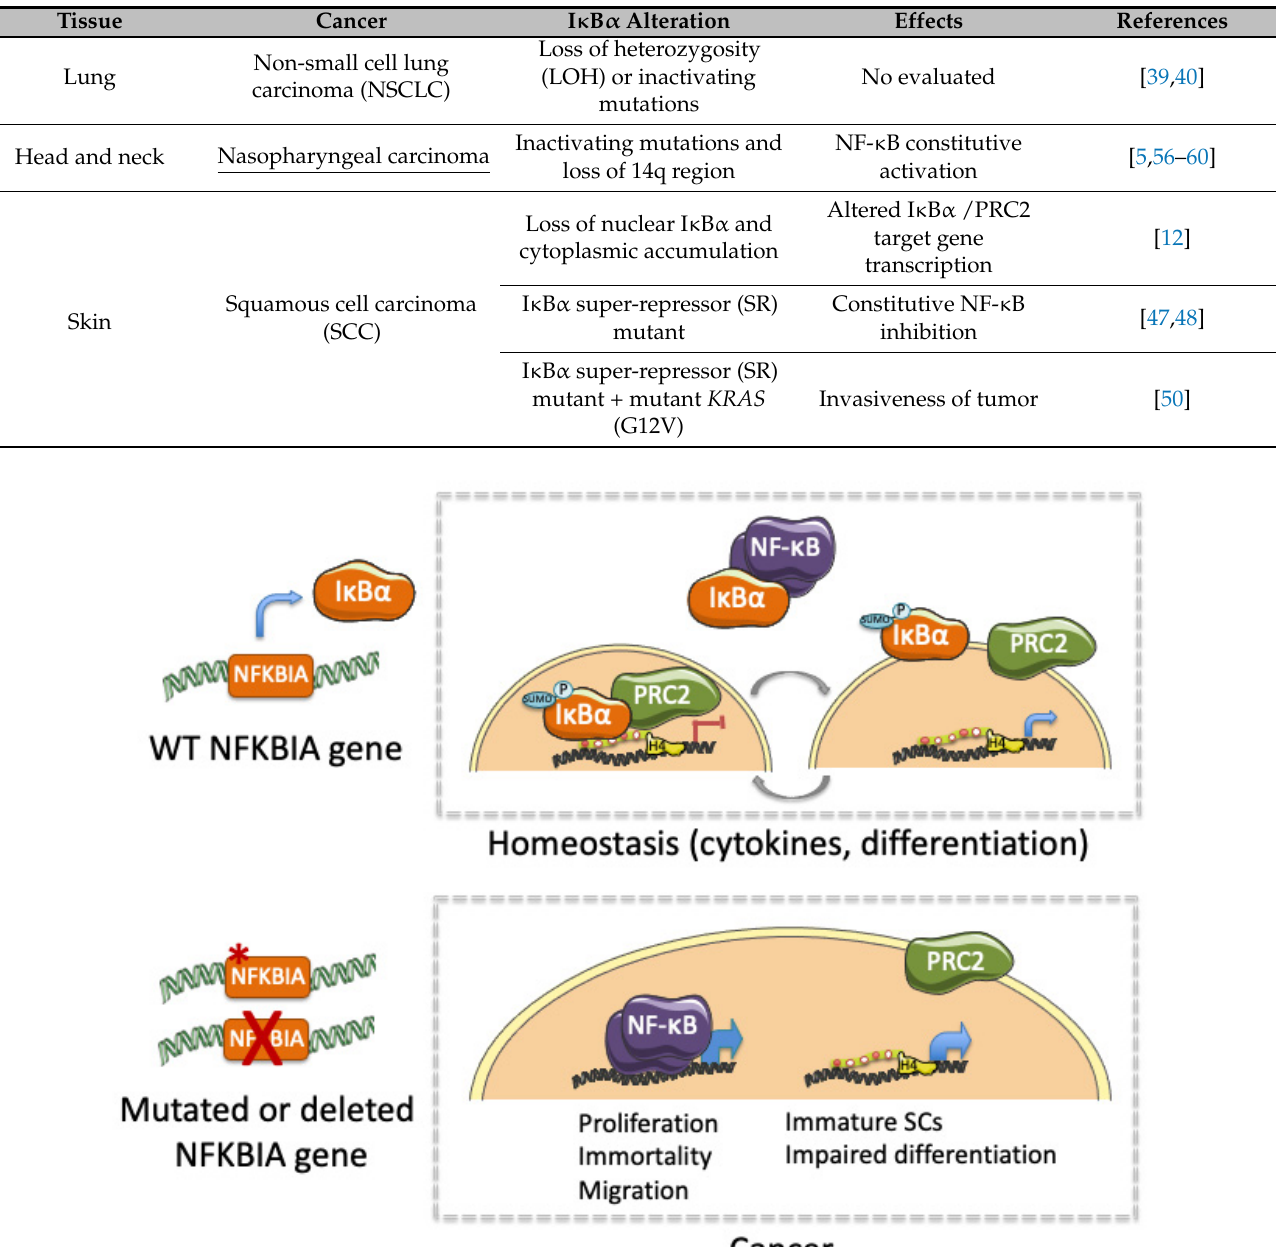
Figure 2. Graphical representation of the functional impact of I κ B α under physiological conditions (homeostasis) and following genetic or functional alteration (cancer).